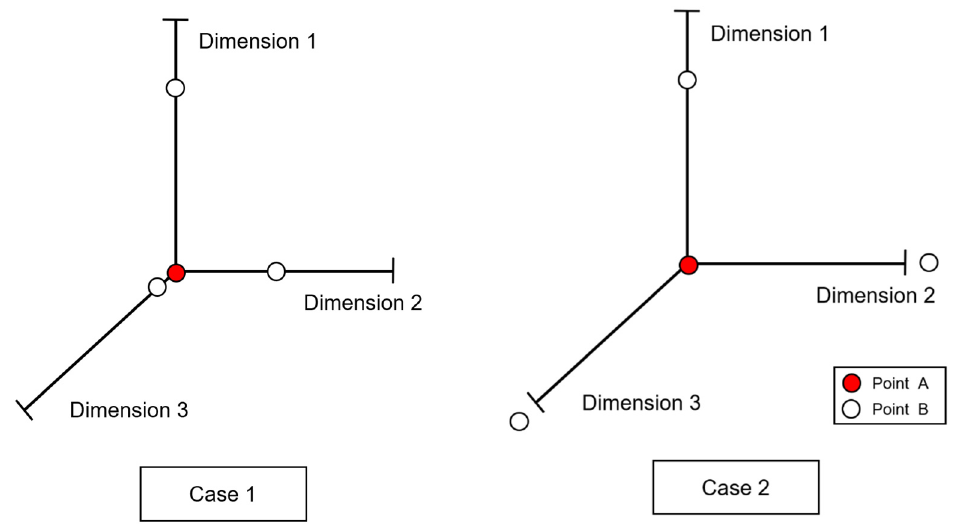
Figure 1. Determining neighbors for data with three variables.